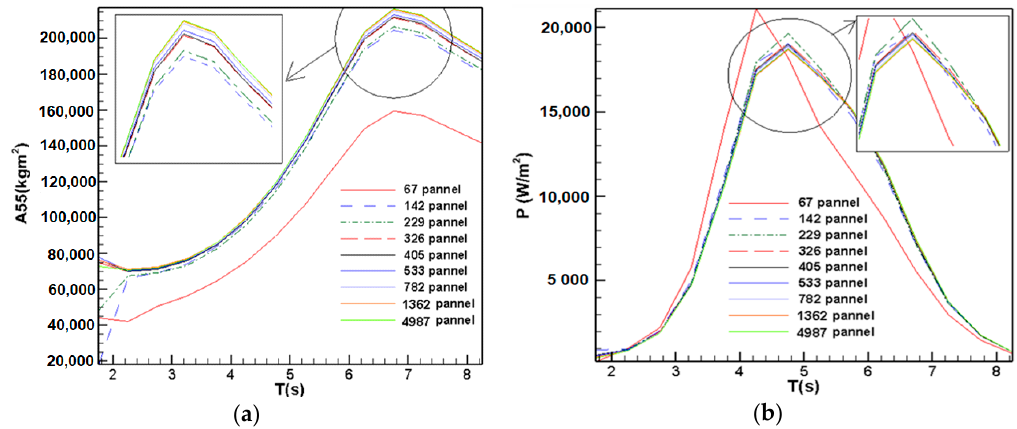
Figure 8. Comparison of ( a ) the added pitch moment of inertia A 55 and ( b ) the power obtained from the converter for different panel quantity